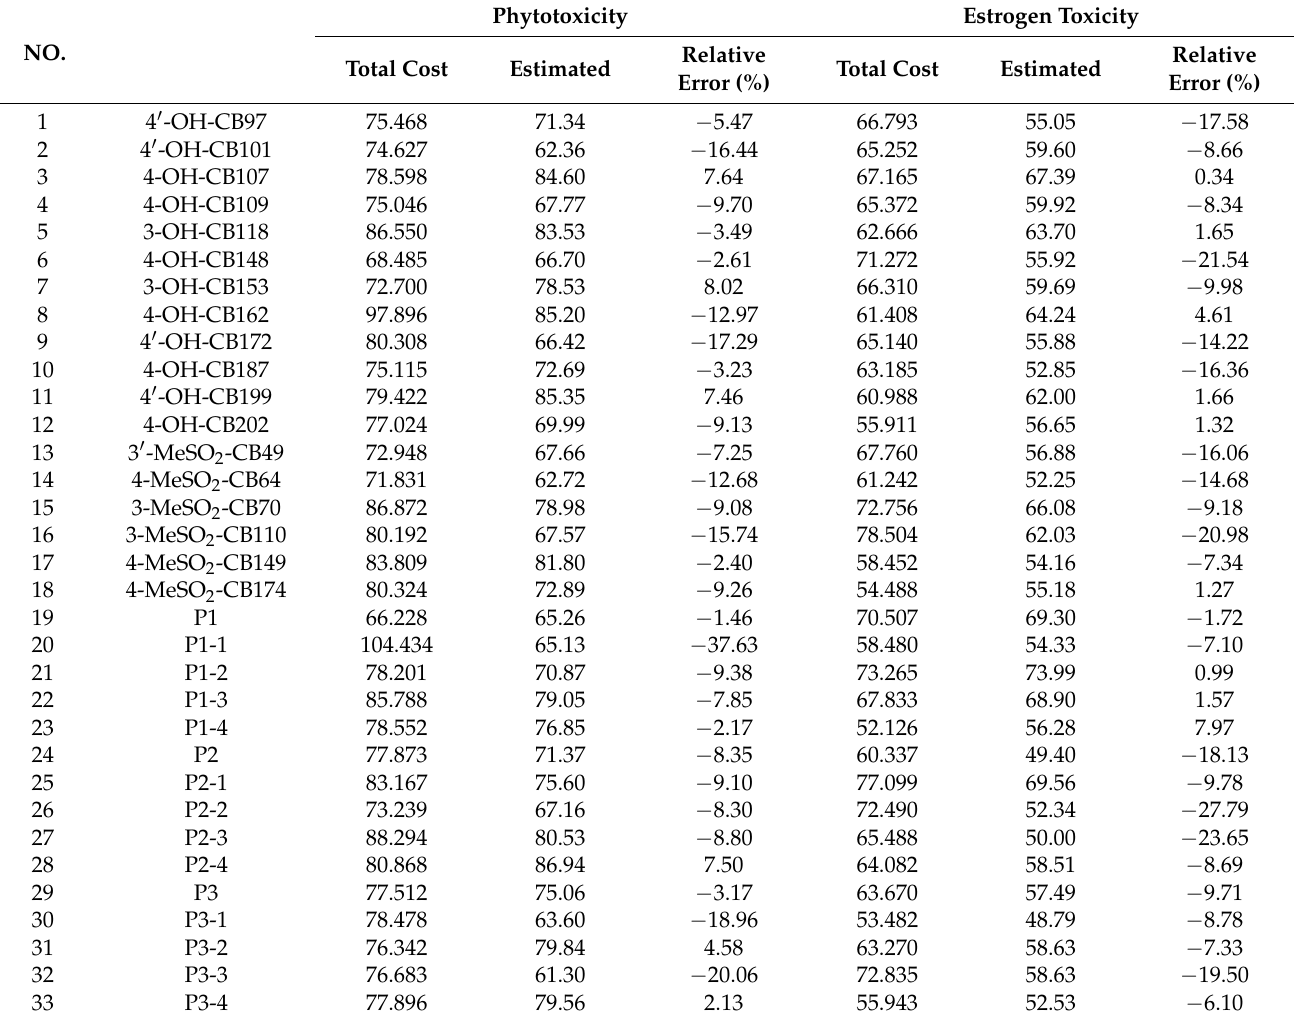
Table 4. The total score and its estimated value of PCBs and their metabolites containing different chemical